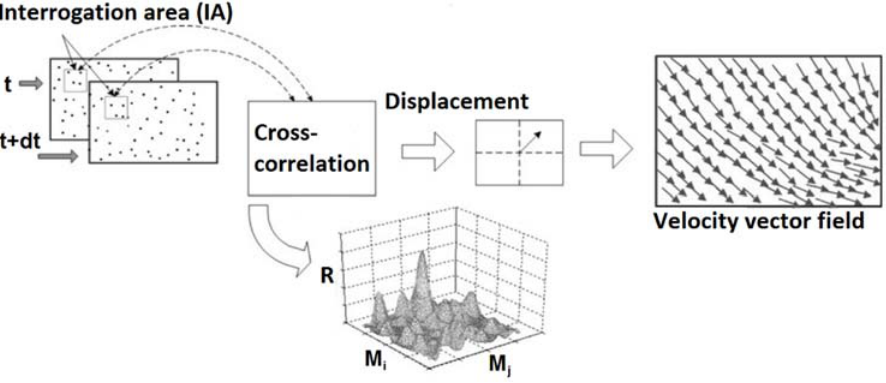
Figure 4. Flow chart of the Large Scale Particle Image Velocimetry (LSPIV) algorithm [33].